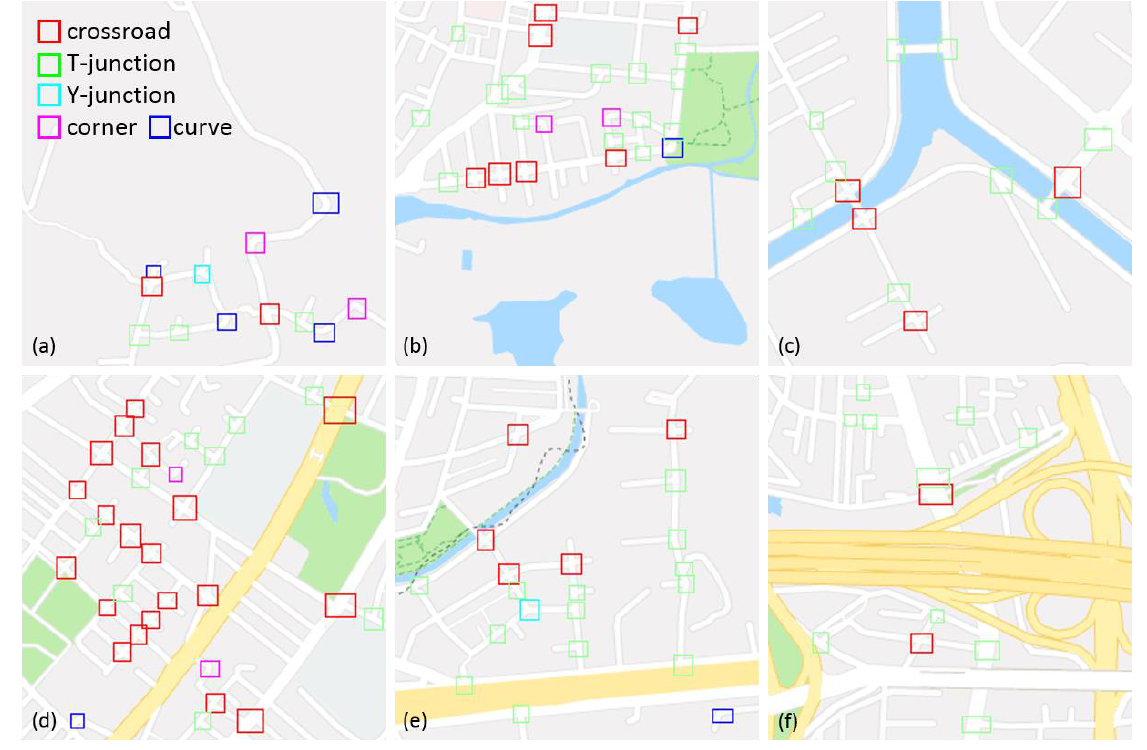
Figure 9. Road characteristics detection results using Faster R-CNN: ( a ) 54897_28039_16, ( b ) 54880_28041_16, ( c ) 54876_28052_16, ( d ) 54873_28067_16, ( e ) 54908_28051_16, and ( f ) 54888_28049_16.